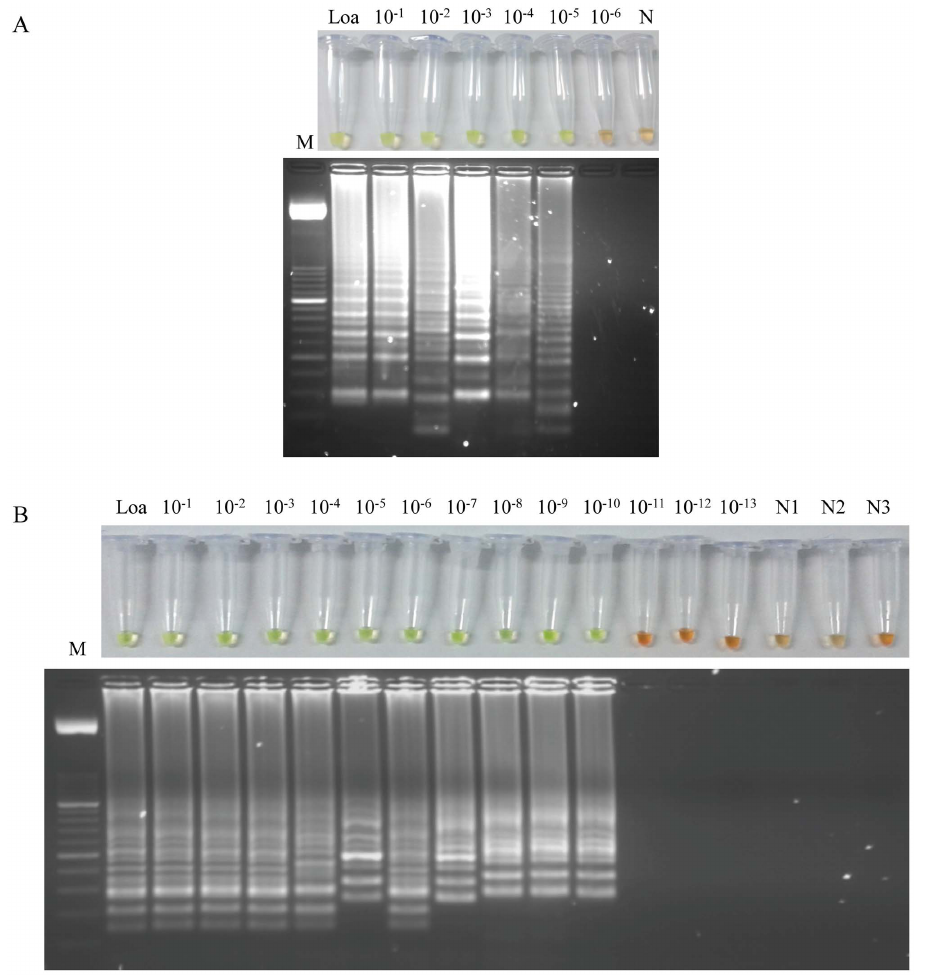
Figure 4. Sensitivity assessment of the LAMP assay for Loaloa using serial dilutions of genomic DNA by the addition of SYBR Green I or by visualization on agarose gel stained with ethidium bromide. (A) Sensitivity assessment performed with a thermocycler. (B) Sensitivity assessment performed with a heating block. Lane Loa: genomic DNA from Loa loa (5 ng); lanes 10 2 1 –10 2 13 : 10-fold serially dilutions; lanes N, N1, N2, N3: negative controls (no DNA template). Lane M: 50 bp DNA ladder (Molecular weight marker XIII, Roche).